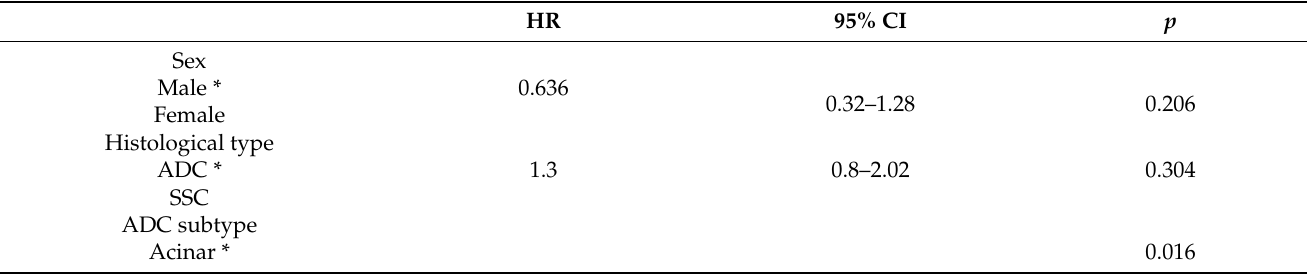
Table 5. Cox regression uninominal analysis of OS according to the examined